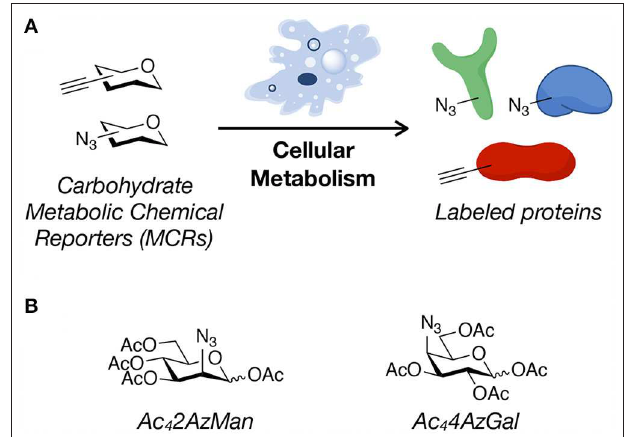
FIGURE 1 | Metabolic chemical reporters. (A) Metabolic chemical reporters (MCRs) of protein glycosylation are traditionally per-O-acetylated, azide- or alkyne-bearing analogs of naturally-occurring monosaccharides. Upon treatment of living cells, MCRs can then be metabolized, resulting in protein labeling. (B) The structure of the potential MCRs studied here, 2-azido-2-deoxy-mannose (Ac 4 2AzMan) and 4-azido-4-deoxy-galactose (Ac 4